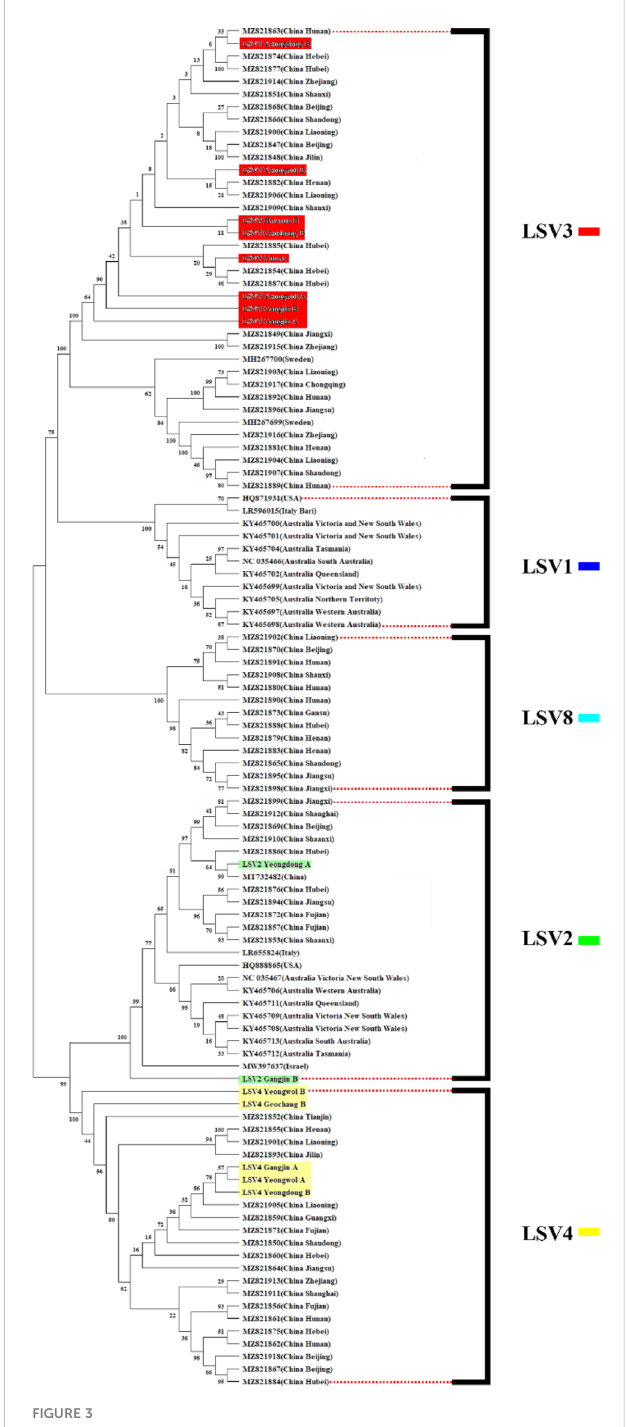
FIGURE 3 Phylogenetic tree visualizing and describing the relatedness for RNA- dependent RNA polymerase (RdRp) regions genetic relationships between Lake Sinai virus 1, 2, 3, 4 and 8 (LSV1, 2, 3, 4, and 8) sequences using maximum likelihood method. The tree was developed using LSV2 (green), LSV3 (red), LSV4 (yellow) sequences detected in virome analysis, and LSV1, 2, 3, 4 and 8 (black) with complete sequences reported in the NCBI GenBank database. The bootstrap value was from 500 replicates and nucleotide distance was measured by Jukes-Cantor method. This tree is analyzed and visualized by MEGA11 using 94 sequences reported in NCBI GenBank database and 14 sequences found in this